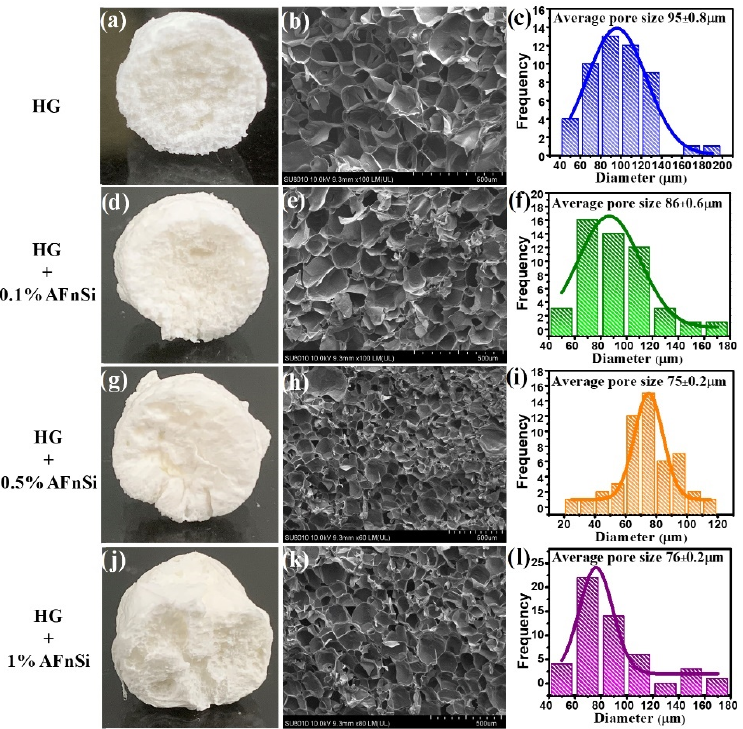
Figure 6. Demonstration of hybrid hydrogel scaffolds with different concentrations of AFnSi, cross- sectional SEM image, and its size distribution histograms. HG ( a – c ), HG+0.1% ( w / v ) AFnSi ( d – f ), HG+0.5% ( w / v ) AFnSi ( g – i ), and HG+1.0% ( w / v ) AFnSi ( j – l ),